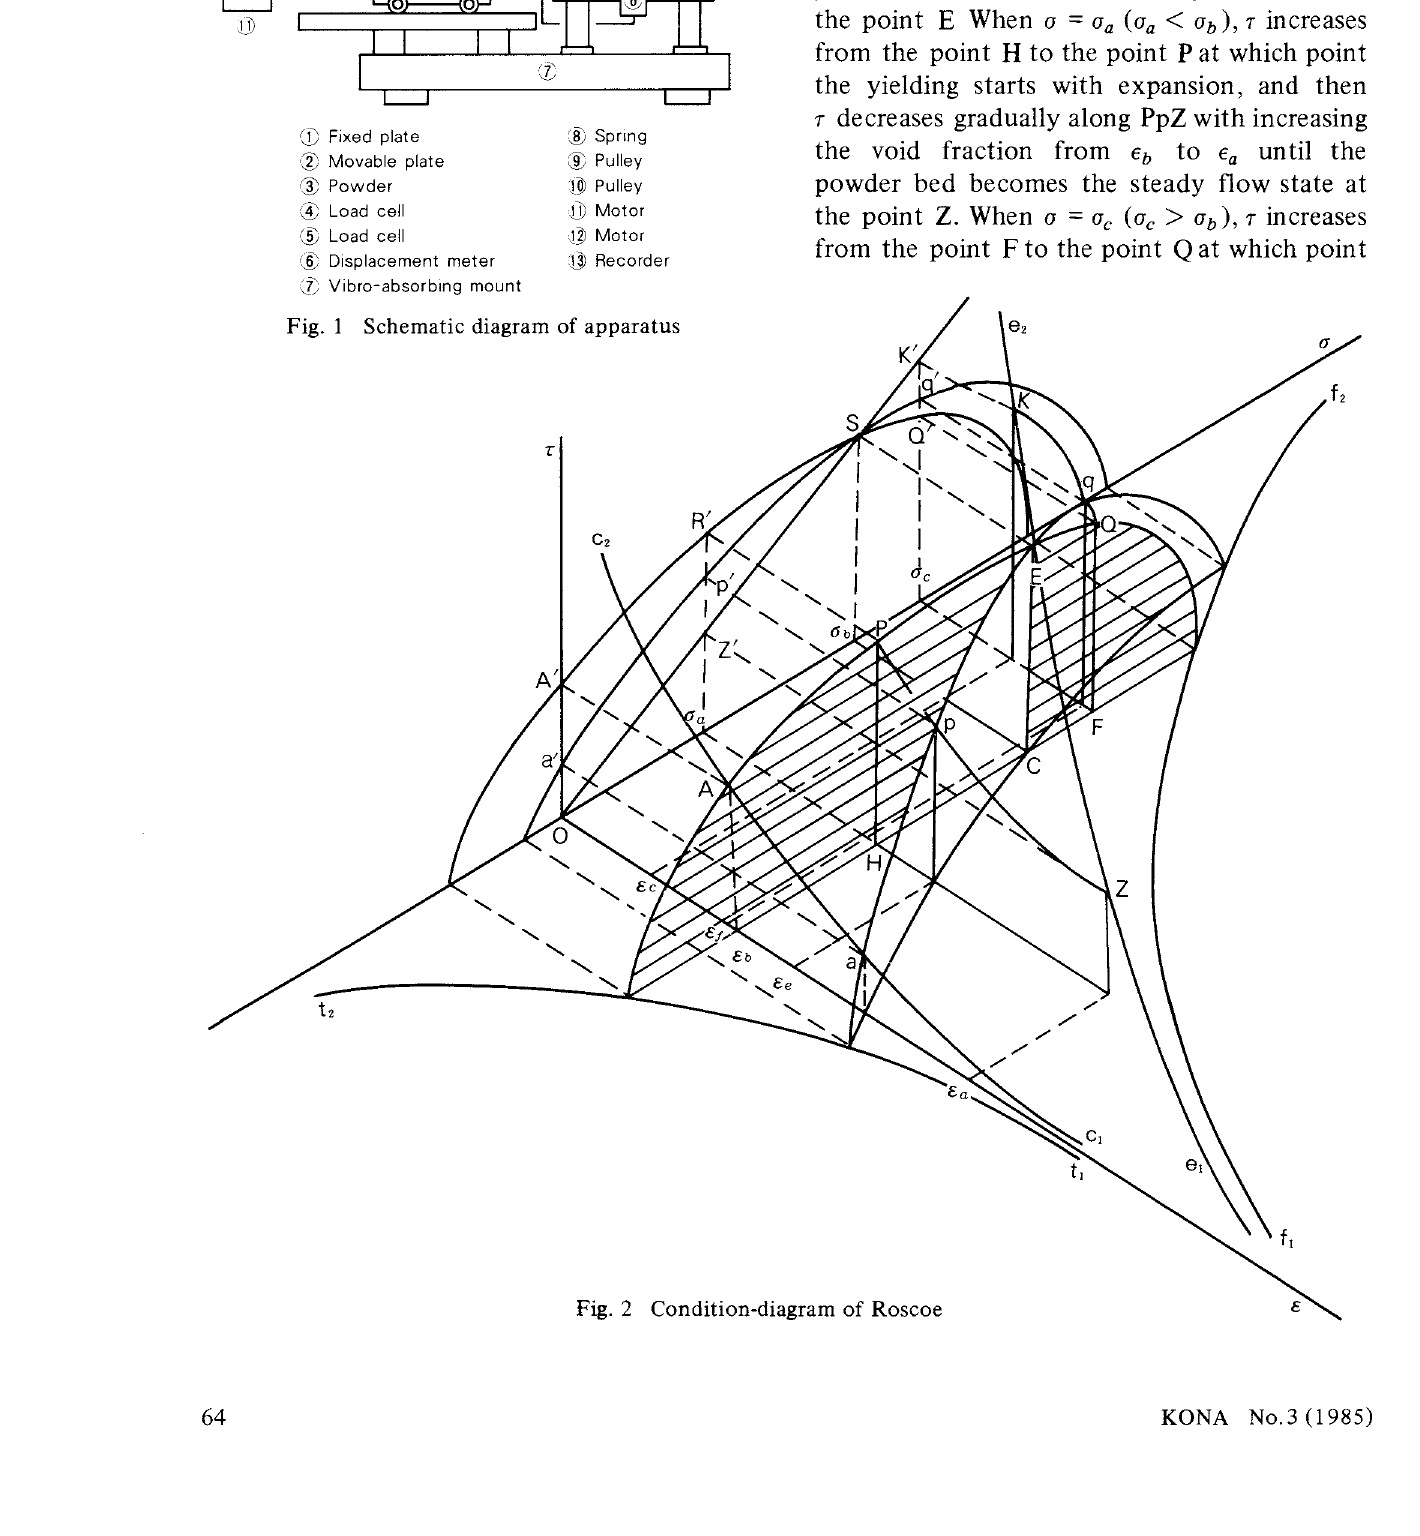
Fig. 1 Schematic diagram of apparatus